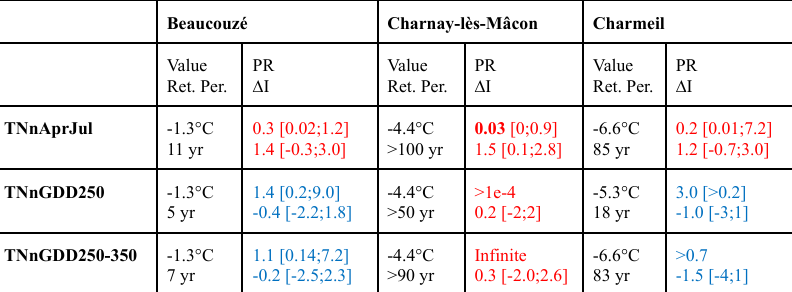
Table 2. Return periods, probability ratios (PRs) and changes in intensities ( (cid:49)I ) obtained from the observations at three stations located as in Fig. 2b. Italics indicate a warming change and bold a cooling